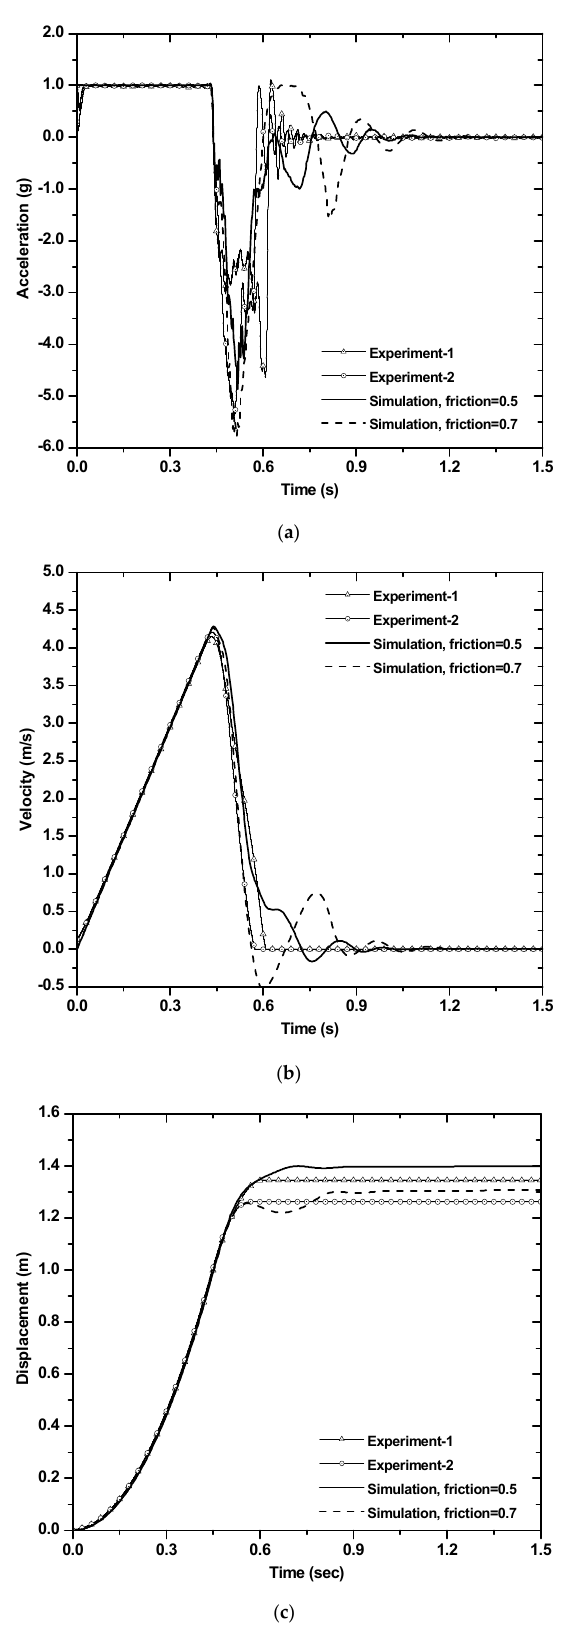
Figure 11. Comparison between the motions of the dropped weight, obtained from tests and simulations (dropped from 1.0 m height): ( a ) acceleration; ( b ) velocity; ( c ) displacement.